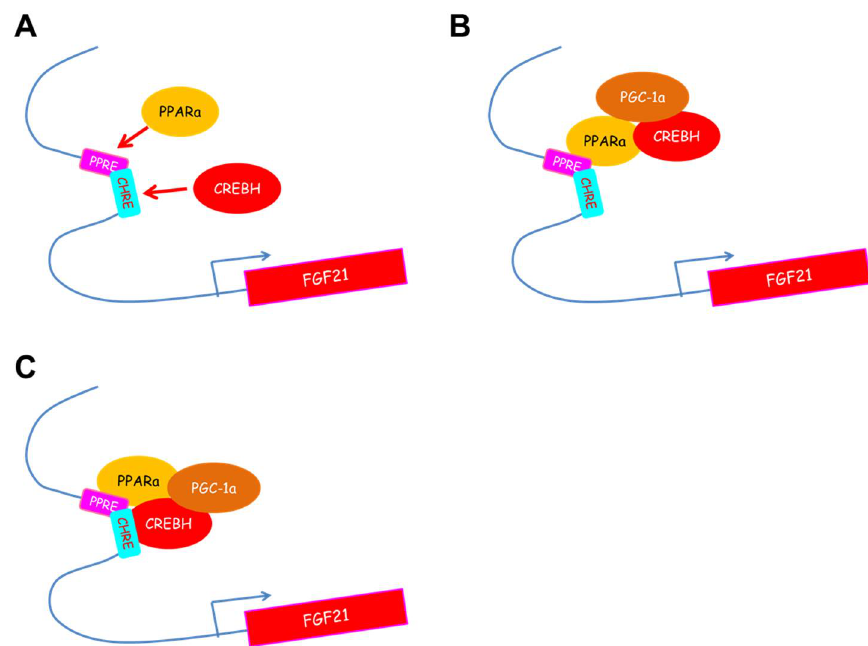
Figure 1. Scheme of Fgf21 transcriptional regulation by the interaction between CREBH and PPARα. Fgf21 promoter has a PPARα-binding site (PPRE) and a CREBH-binding site (CHRE), which are partially overlapped. ( A ) CREBH and PPARα directly bind to their own binding sites on the Fgf21 promoter. ( B ) CREBH regulates PPARα transcriptional activity as a co-activator and by peroxisome proliferator-activated receptor gamma coactivator 1α (PGC-1α) recruiting. ( C ) CREBH and PPARα form a complex on the Fgf21 promoter and synergistically activate Fgf21 expression.